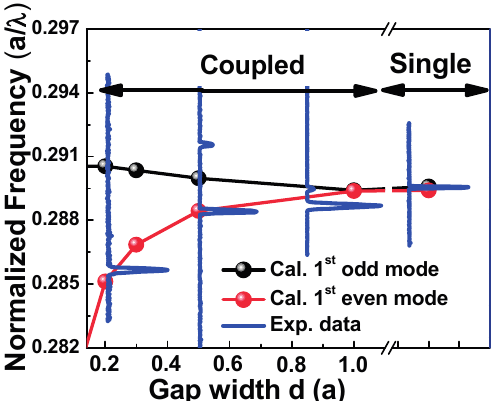
Figure 7. SEM image of a laterally-coupled PhC NB cavity with lattice constant ( a = 450 nm) and gap distant ( d = 0.5 a ).